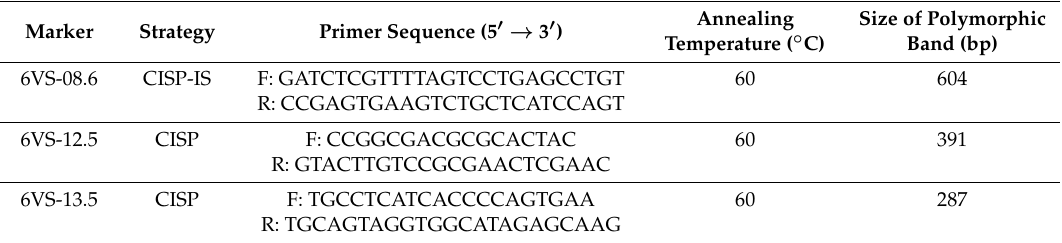
Table 3. 6VS-specific markers newly developed in this